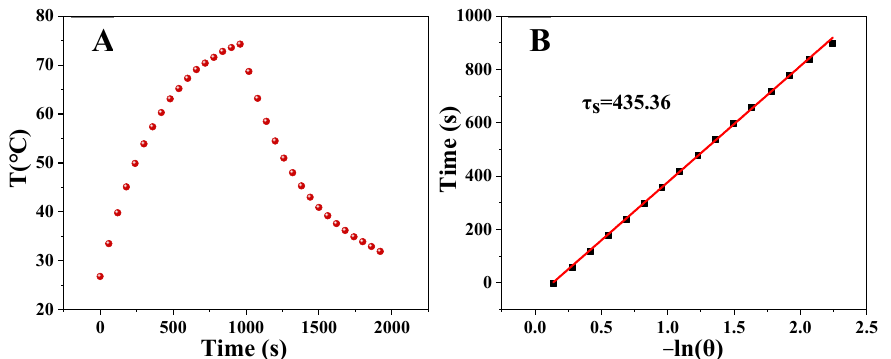
Figure 5. ( A ) Photothermal effect of PEG-MoS 2 NFs before and after irradiation for 16 min by 808 nm laser at a power density of 1.5 W/cm 2 . ( B ) Graph of the relationship between the cooling time (after 16 min) and the negative natural logarithm of the driving force temperature obtained from the cooling phase.